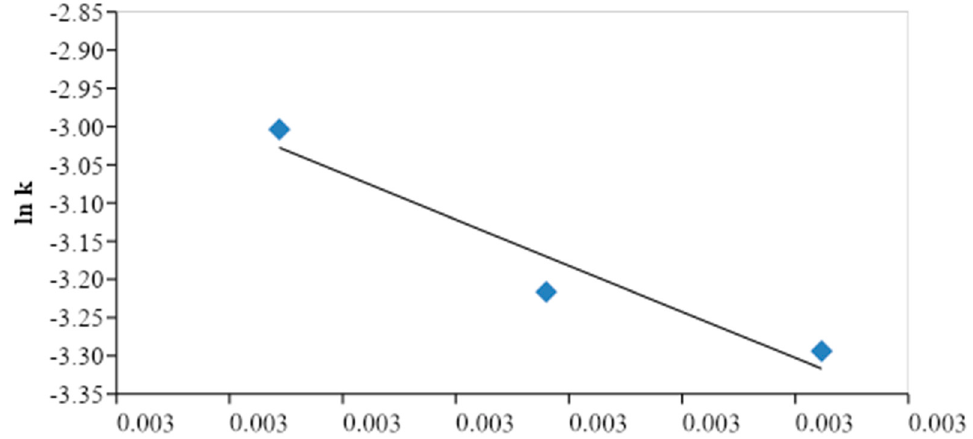
Figure 6. Plot of rate constant (ln k ) versus the reciprocal of the reaction temperature (1/ T ).